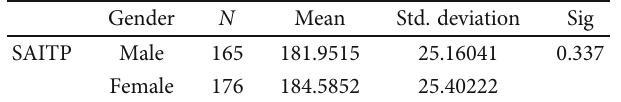
Table 2: t -test for